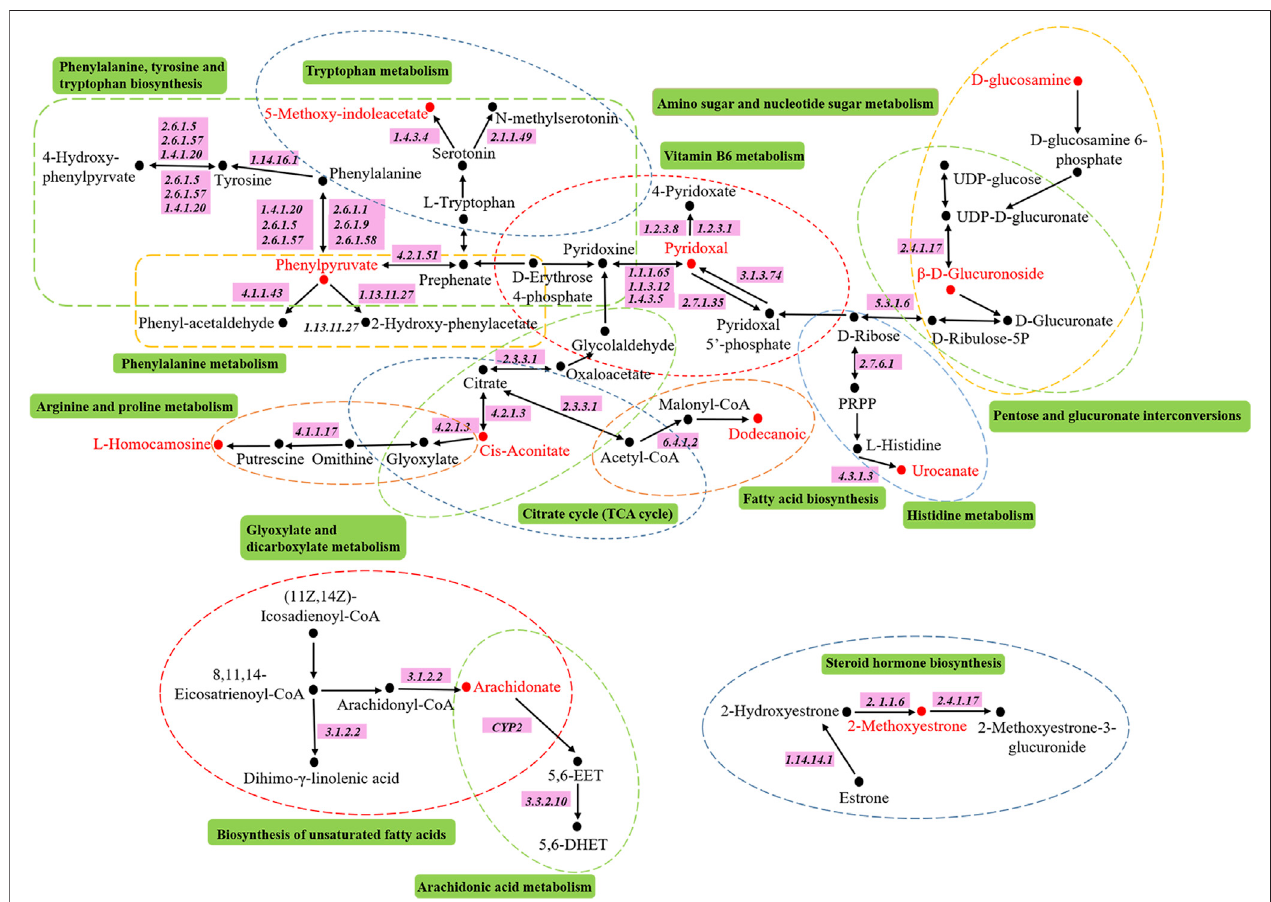
FIGURE 8 | The metabolic pathways associated with all potential biomarkers in KEGG. Red represents the biomarkers detected in our research.